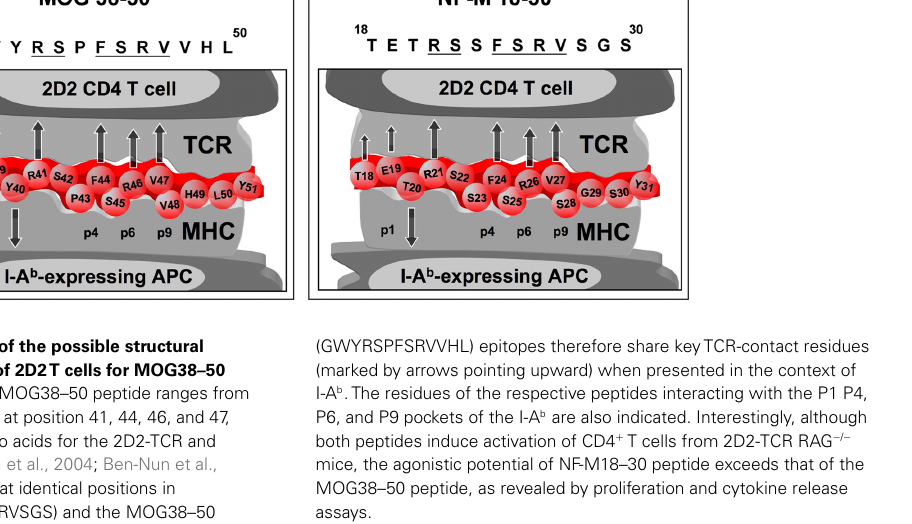
Table 1 | Parameters governing the pathogenic potential of autoreactiveT